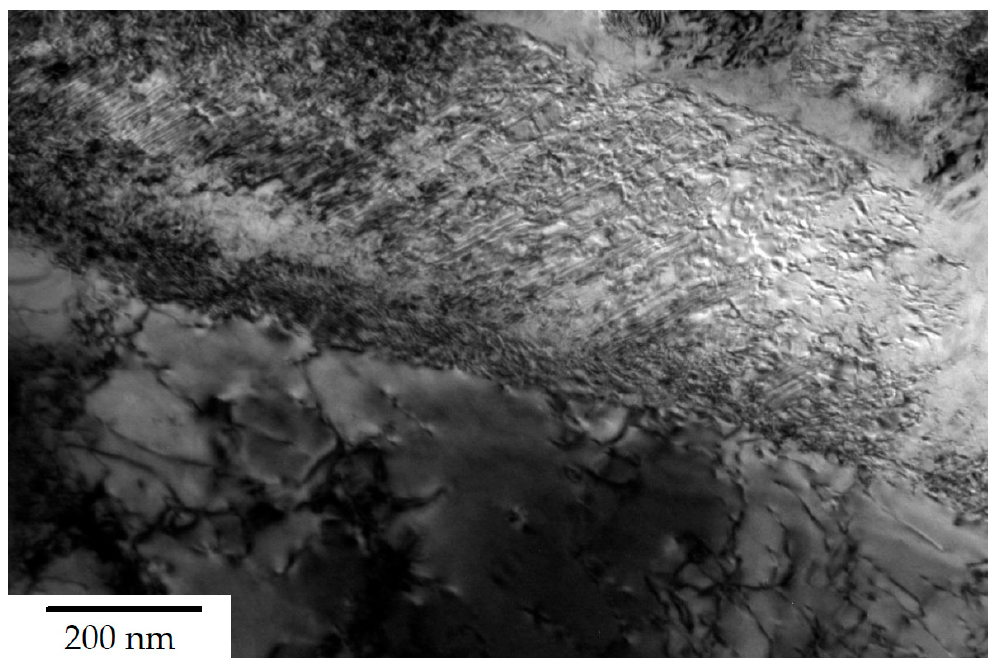
Figure 4. HRTEM micrograph of steel A0 after heat treatment acc. to route ① .